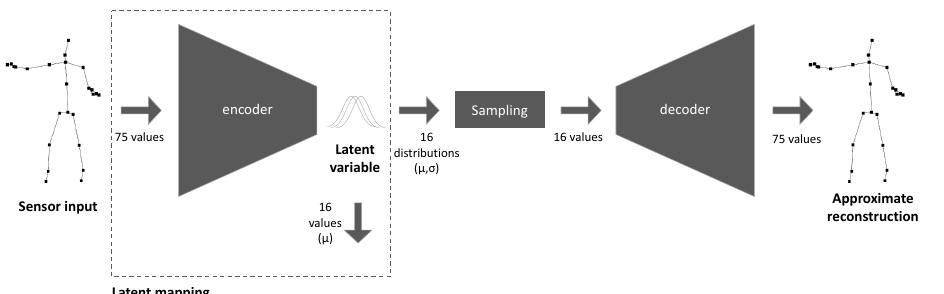
Figure 2. Overview of a Variational Autoencoder (VAE) with a box showing the subsection re- appropriated as the latent